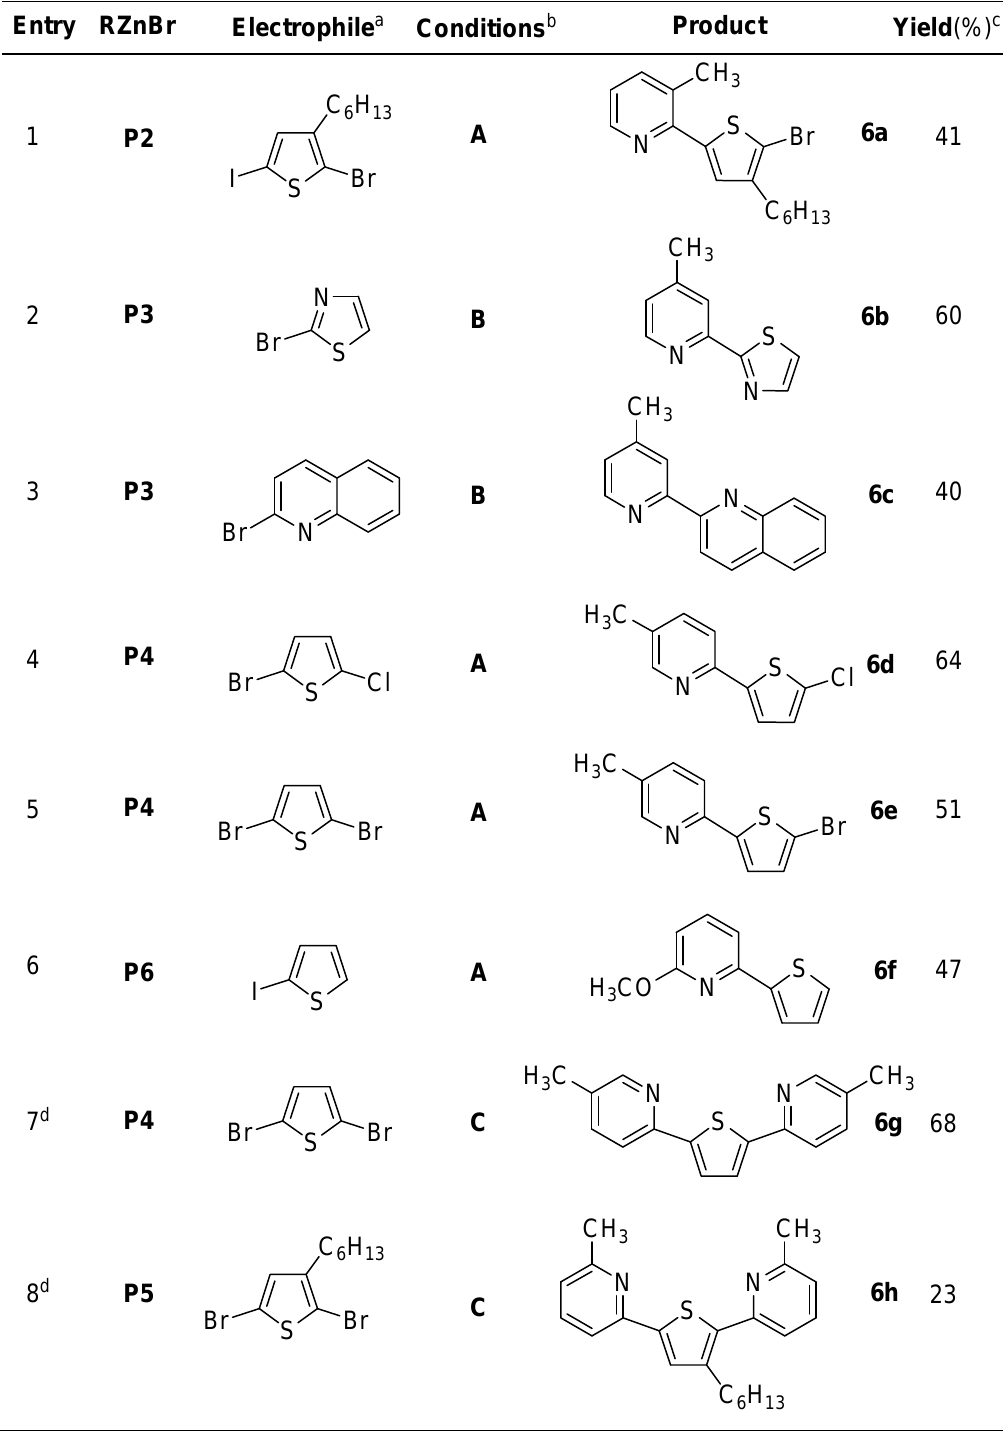
Table 6. More coupling reactions of 2-pyridylzincs with heteroaryl halides.